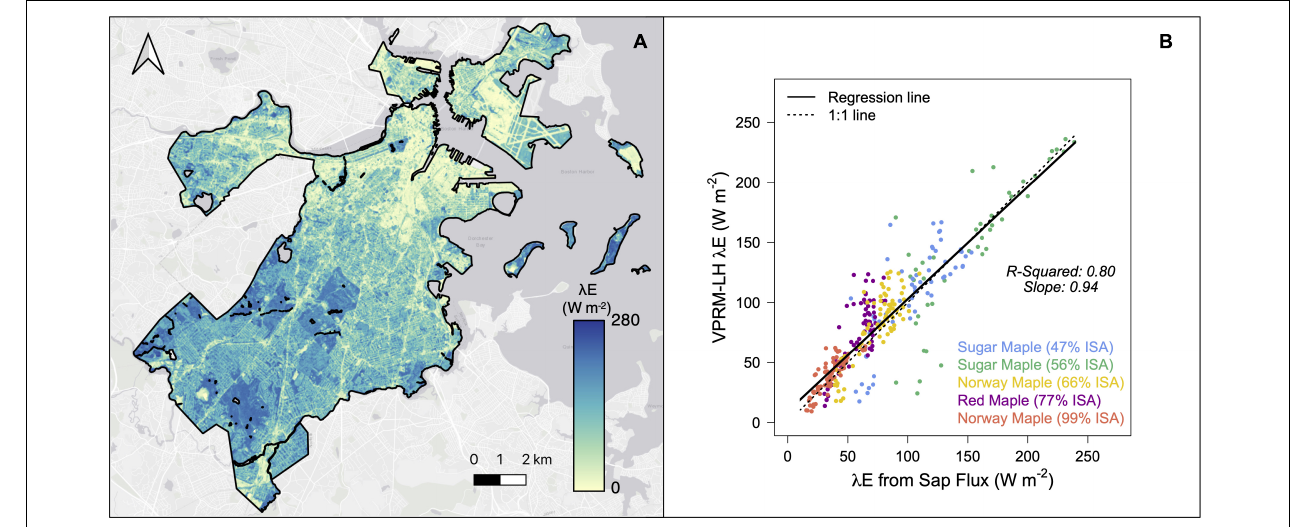
FIGURE 2 | (A) Average 14:00 EDT λ E at 30 m resolution across Boston, MA, United States under heatwave conditions. (B) Daytime (9:30–14:30) hourly estimated λ E vs. λ E derived from sap flux measurements between July and September